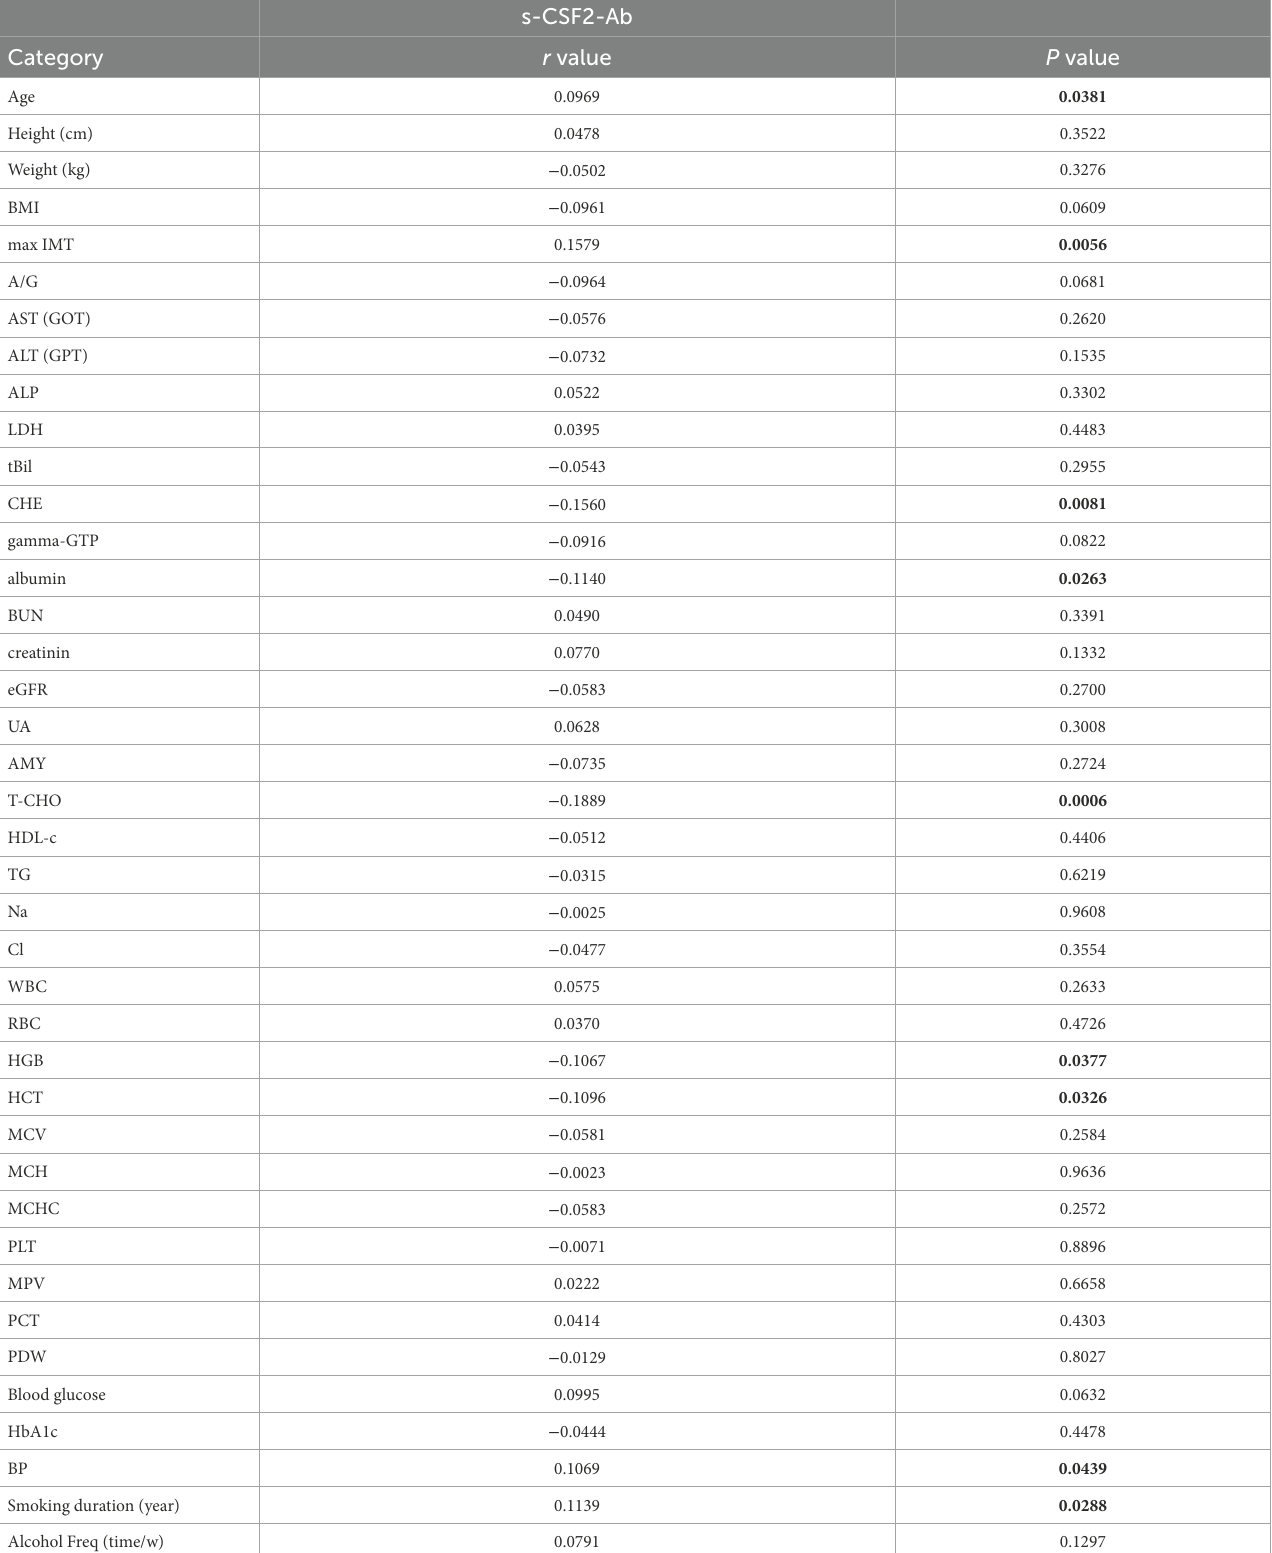
TABLE 5 Correlation analysis of s-CSF2-Ab levels with data from subjects in the Sawara Hospital